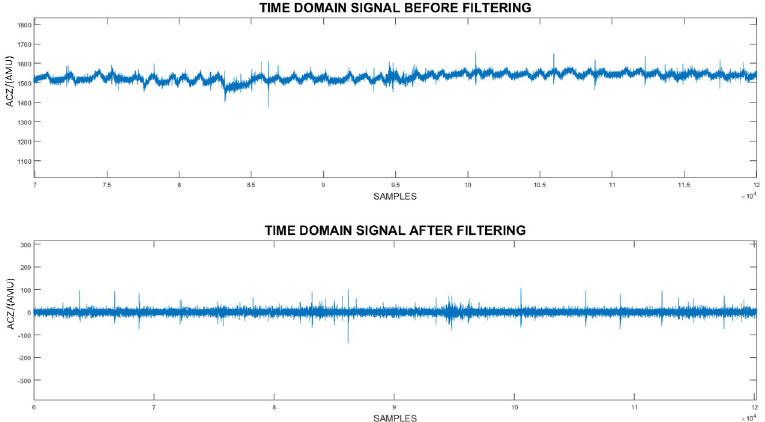
Fig 8. The raw time domain data captured from the sensor vs the time domain data when a custom high pass filter was applied (zoomed-in). In this figure a zoomed-in comparison between the filtered and non filtered time domain data can be made. Z-Axis accelerometric data from a segment of a session is used for the comparison. In the non filtered signal a sinusoidal pattern can be observed. It is due to the effect maternal breathing has on the sensor. However, as it can be observed this pattern was removed when the custom filter was